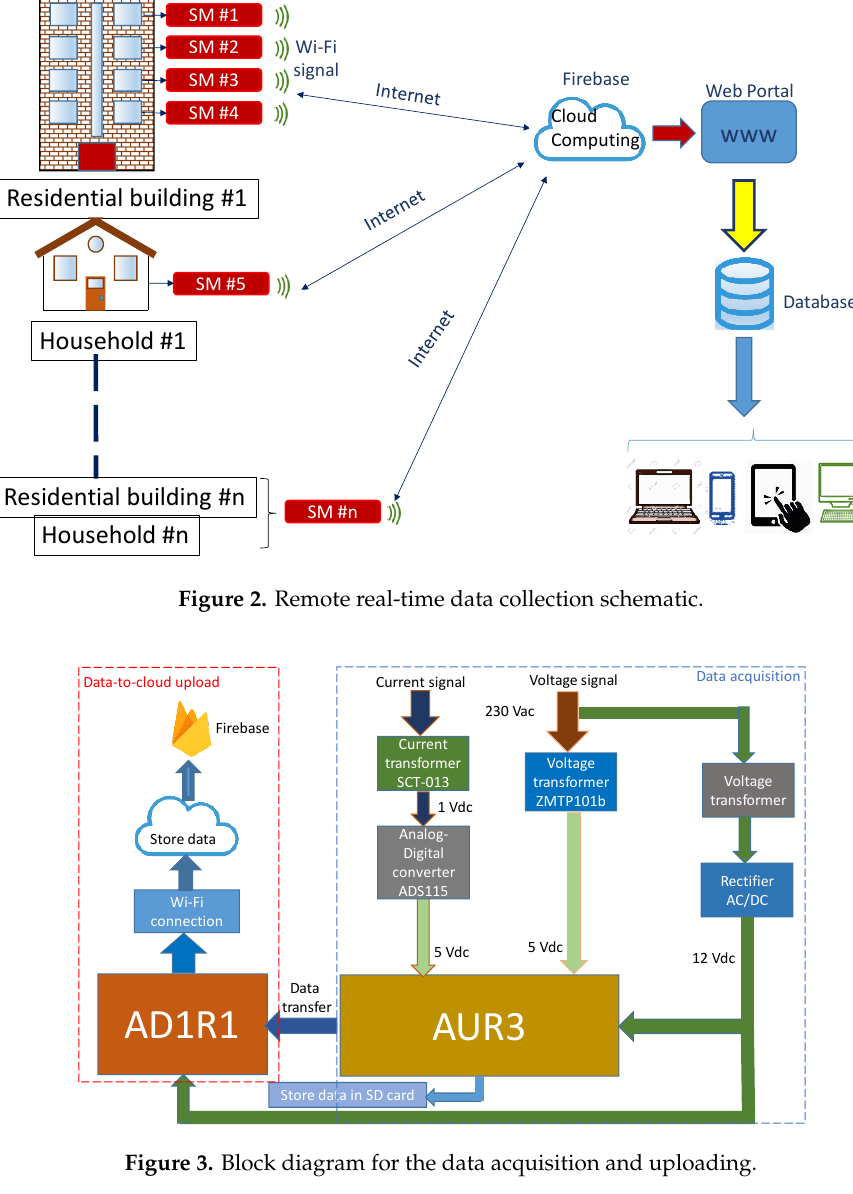
Figure 1. Temporal framework for analyzing the electrical energy system.